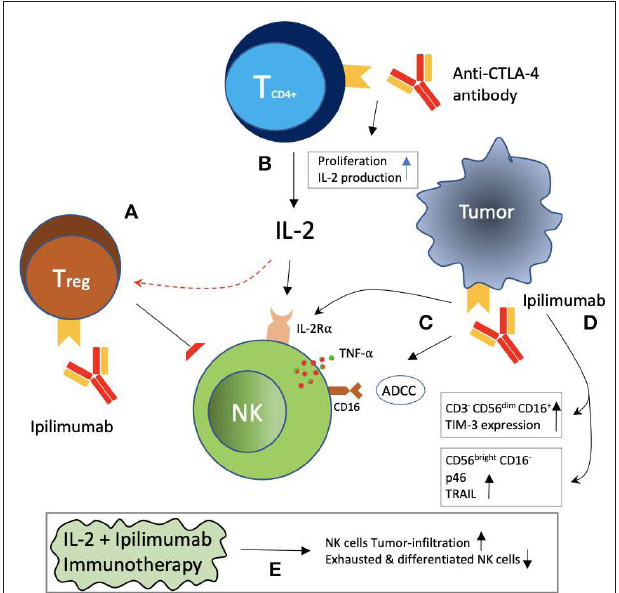
FIGURE 4 | Indirect effects of CTLA-4 blockade on NK cells. (A) Treg increase was correlated with NK cell suppression and decrease IL-2 availability to NK cells, which may be reversed with CTLA-4 blockade. (B) CTLA-4 blockade with antibodies increased CD4 + T-cell proliferation and IL-2 production. (C) Ipilimumab blockade of CTLA-4 on tumor cells has been reported to be associated with ADCC, TNF- α release by NK cells, and induction of the IL-2R α chain on NK cells. (D) Ipilimumab was associated with an increased frequency of CD3 − CD56 dim CD16 + NK cells with increased TIM-3 expression. CD56 bright CD16 − NK cells with increased expression of p46 receptor and TRAIL have also been reported. (E) A combination of IL-2 plus ipilimumab was reported to be associated with increased NK cell infiltration of tumor, as well as a decrease in exhausted and differentiated NK